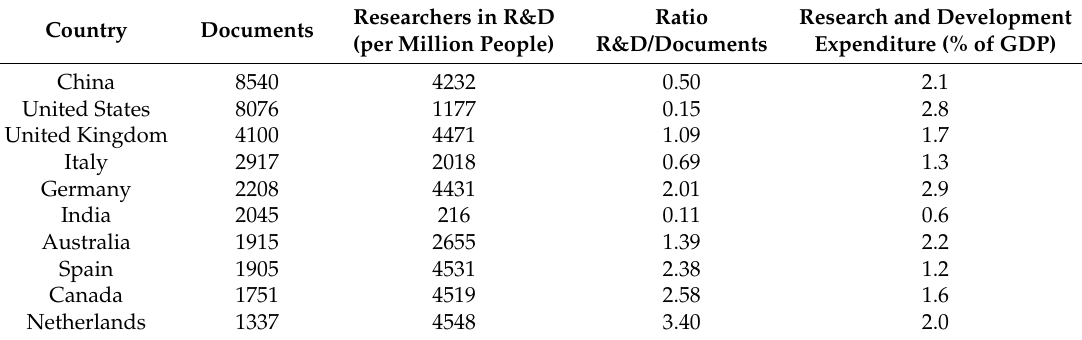
Table 6. Research information by